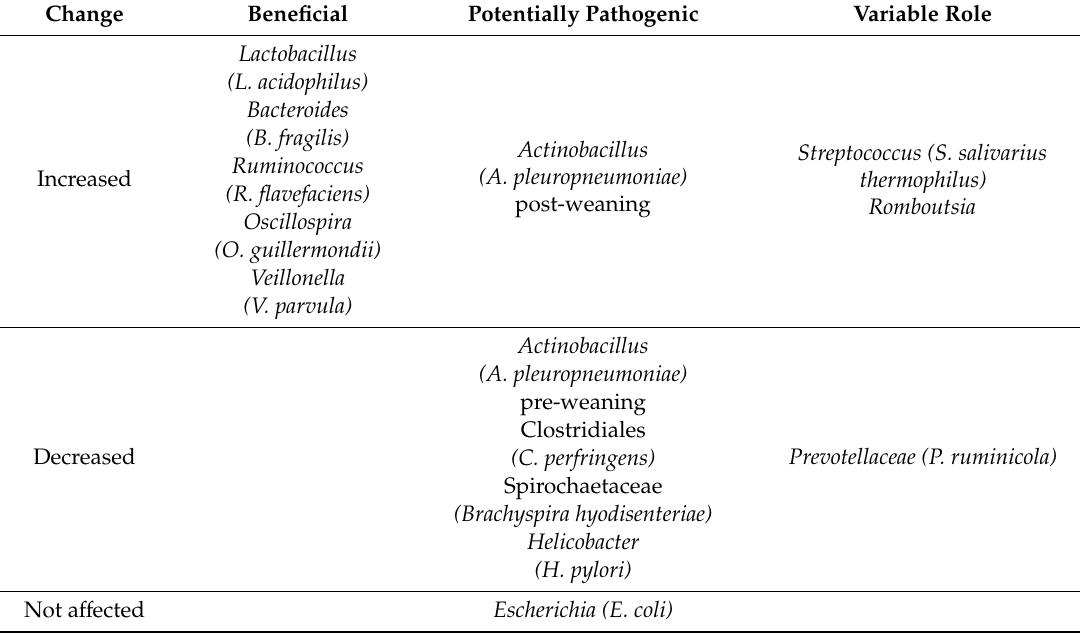
Table 1. Changes in the relative abundance of bacterial taxa in response to Tonisity Px supplementation. Representative species within each observed taxa are presented in